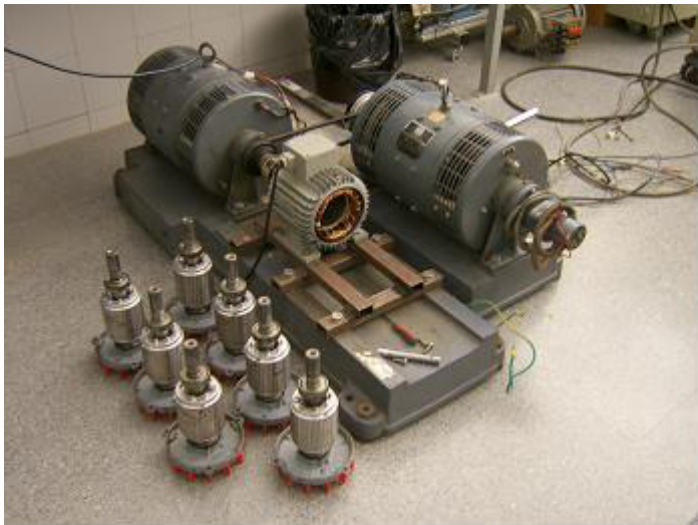
Figure 10. T-bench of the tested rotors.